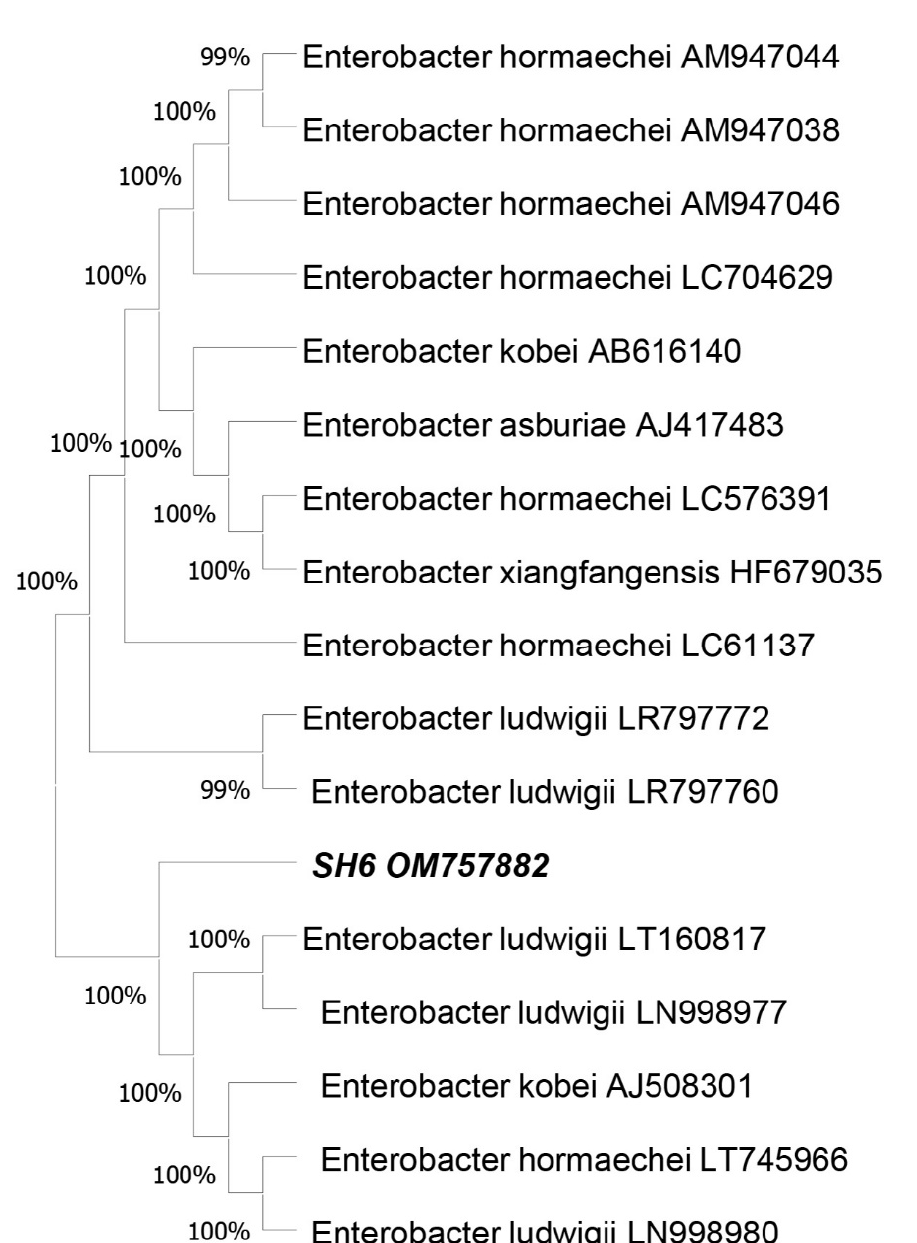
Figure 1. Phylogenic tree of SH-6 16S rRNA with 16S rRNA of other strains of Enterobacter ludwigii . The phylogenetic tree was constructed using the MEGA 10software.